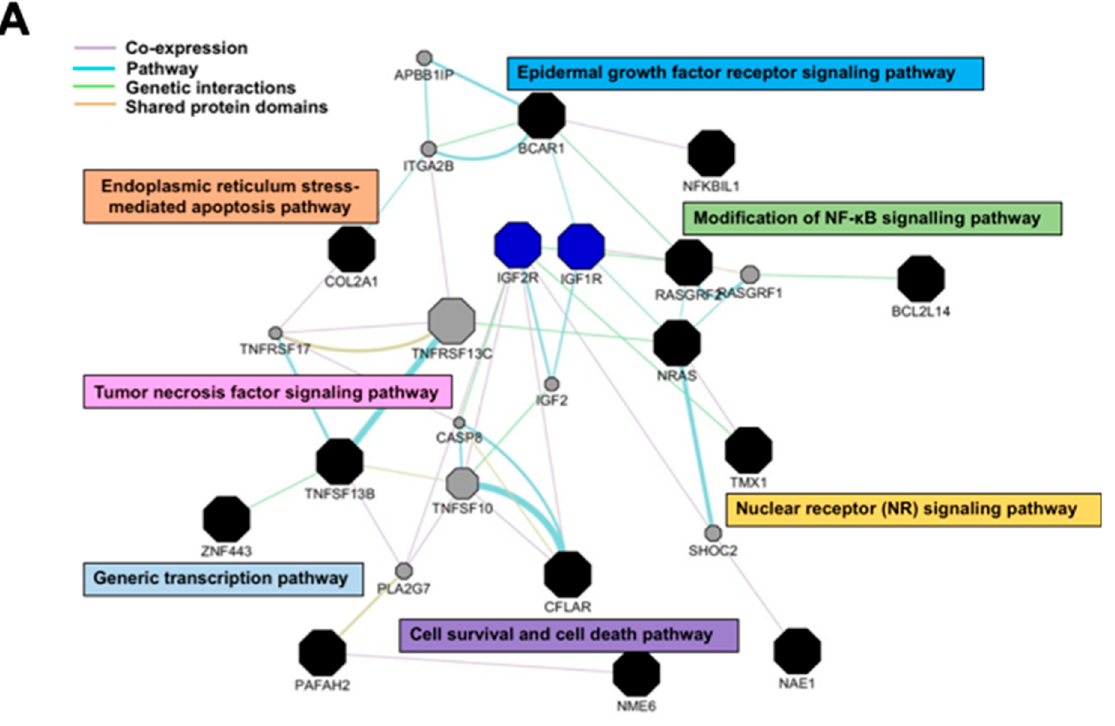
Figure 5. Cont . Figure 5.